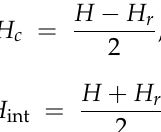
, and coordinate of switching r and H . c int